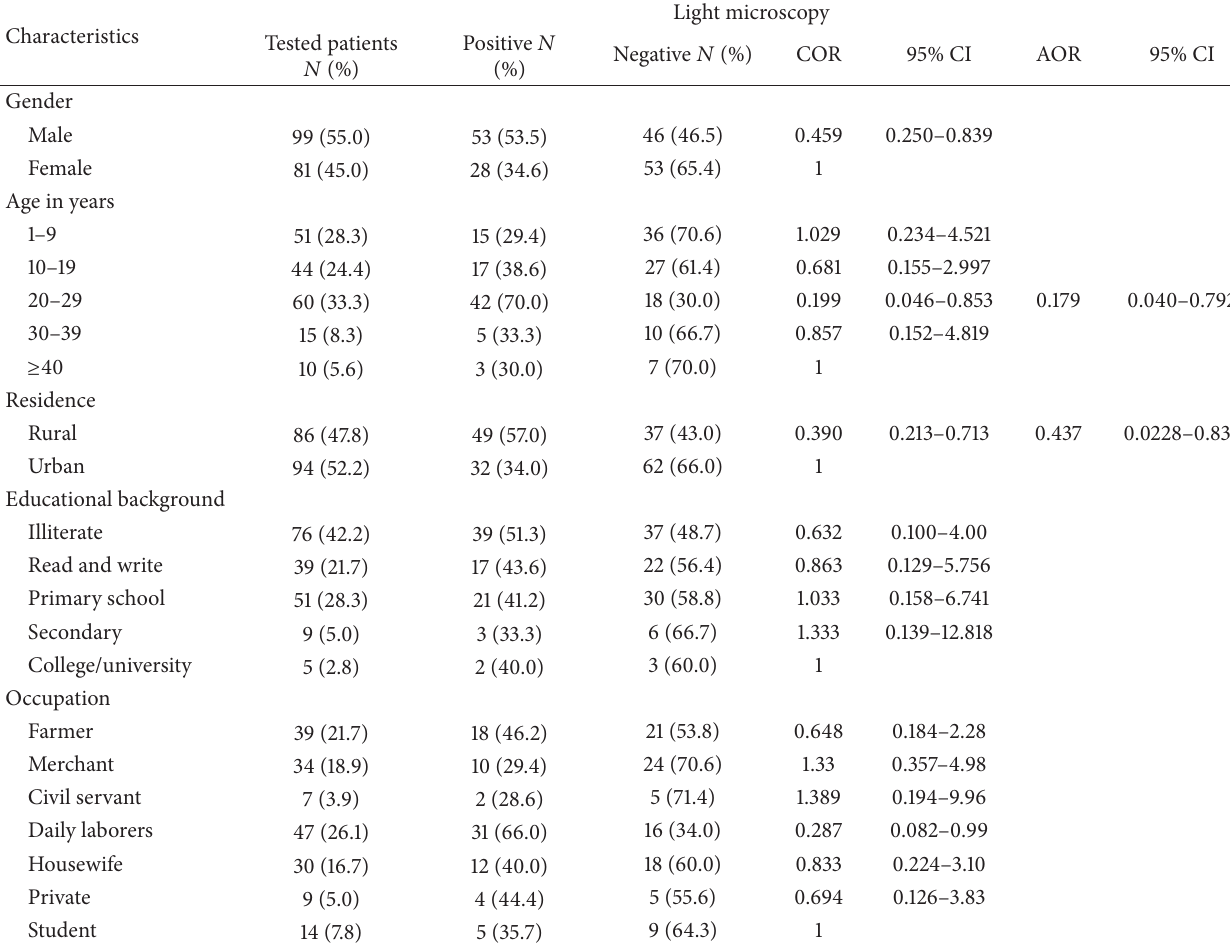
Table 1: Sociodemographic characteristics of patients and malaria positivity by light microscopy Gendewuha health center, Northwest Ethiopia, from June to July, 2013.